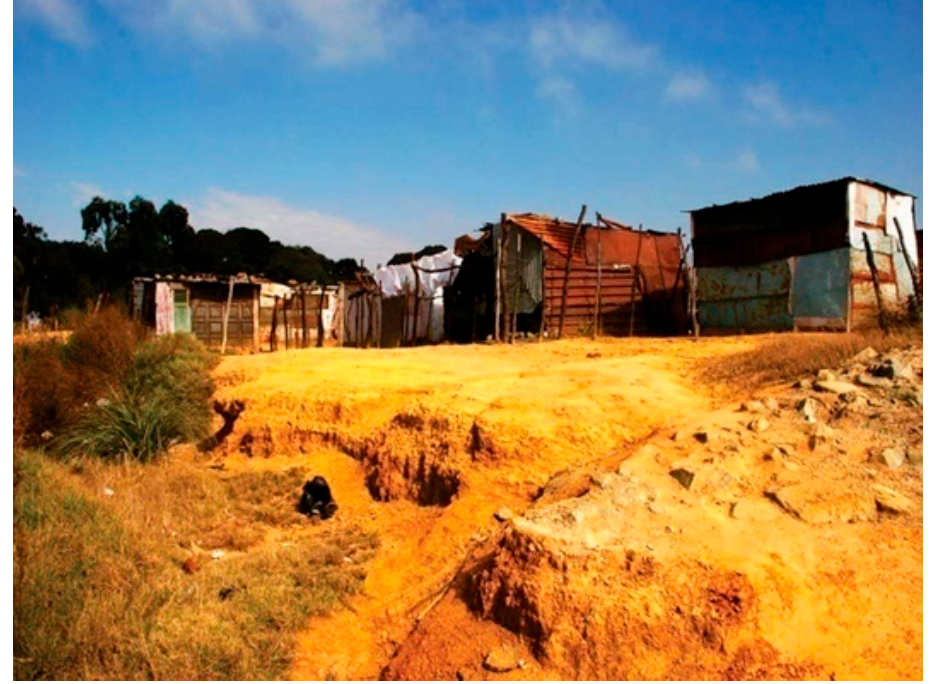
Figure 3. Mining communities in the Witwatersrand goldfields are often built near, or on top of, tailings piles that contain uranium dust. Credit: Stephan du Toit, 2011. Source: http://www.earthmagazine.org/article/all-glitters-acid-mine-drainage-toxic-legacy-gold-mining-south-africa (accessed on 26 March 2016).